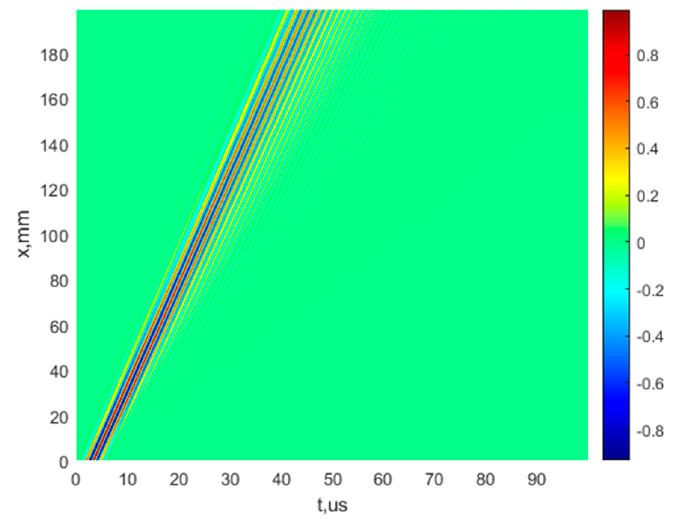
Figure 6. Simulated B-scan image of the S 0 mode at the central frequency of 700 kHz, using the mathematical model.